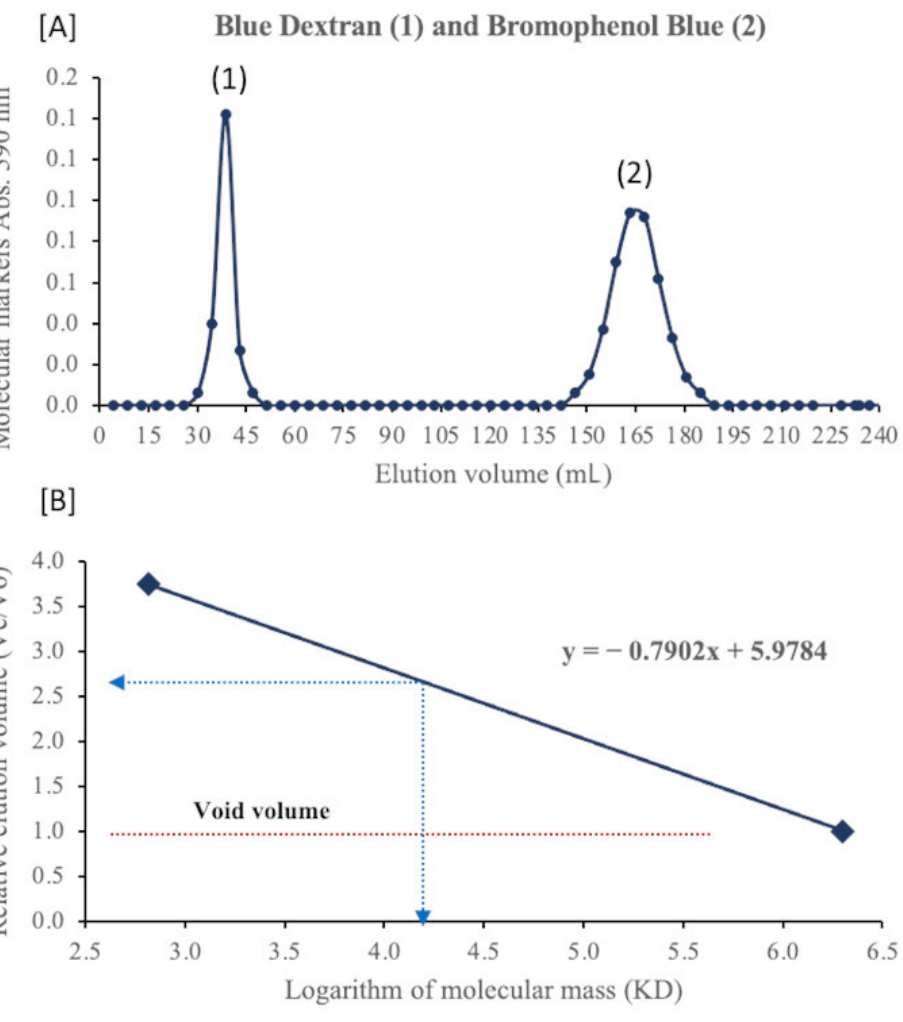
Figure 2. Elution diagram of a mixture of [ A ] molecular markers on Sephadex G-75 in a 0.05 M phosphate buffer, pH 7.2 and [ B ] relative elution volume of antibacterial fraction versus molecular weight for Bromophenol Blue and Blue Dextran.